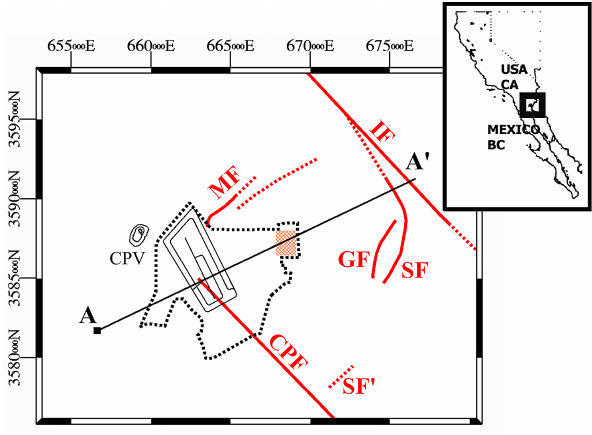
Figure 1. Plan-view map of the study area. The black thick dot- ted line frames the limits of the Cerro Prieto Geothermal Field. The borders of the evaporation pond and the Cerro Prieto vol- cano (CPV) are also shown (thin gray lines). A striped orange rect- angle indicates the extraction area of CPIV which started the op- eration since 2000. Solid red lines are well-known surface traces of tectonic faults. CPF = Cerro Prieto Fault, GF = Guerrero Fault, IF = Imperial Fault, MF = Morelia Fault, SF = Saltillo fault. Dotted red lines are proposed surface fault traces based on mapped fissure zones from González et al. (1998), Glowacka et al. (2006, 2010a, c), Lira (2006) and Suárez-Vidal et al. (2007, 2008). SF’ is continua- tion of Saltillo fault as proposed by Suárez-Vidal et al. (2008). Black square marks the location of the reference, considered stable, re- gion. Black thick line corresponds to the profile A-A’ illustrated in Fig. 3. Modified from Glowacka et al.